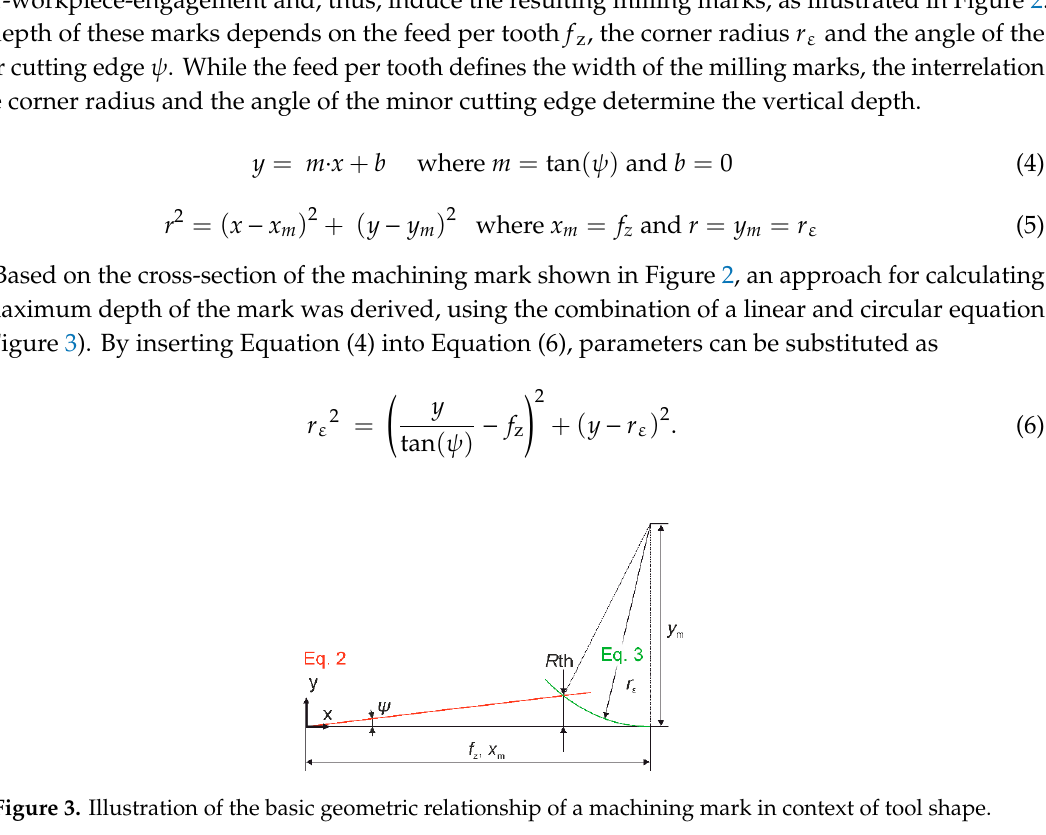
Figure 3. Illustration of the basic geometric relationship of a machining mark in context of tool shape.